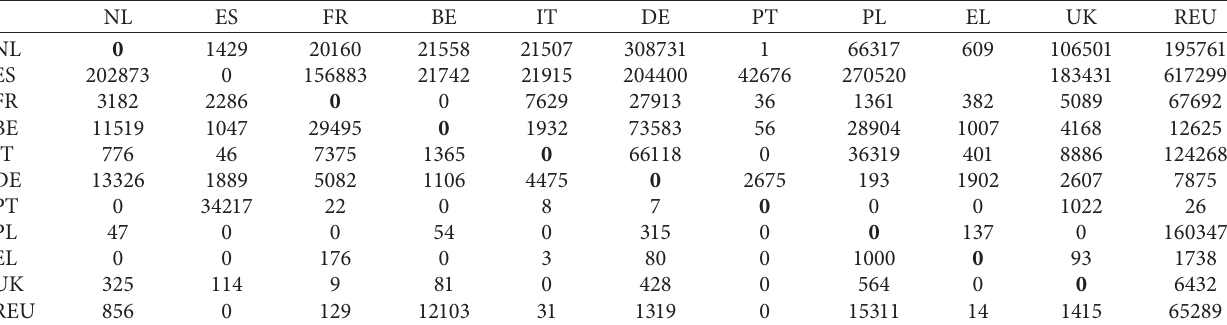
Table 3: Matrix of trade transactions 2002.